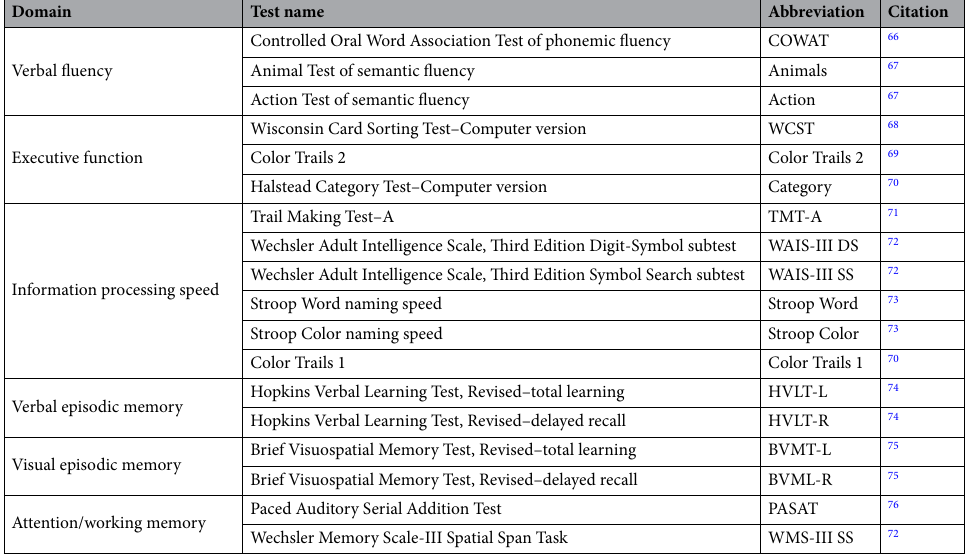
Table 1. Neuropsychological tests administered to all